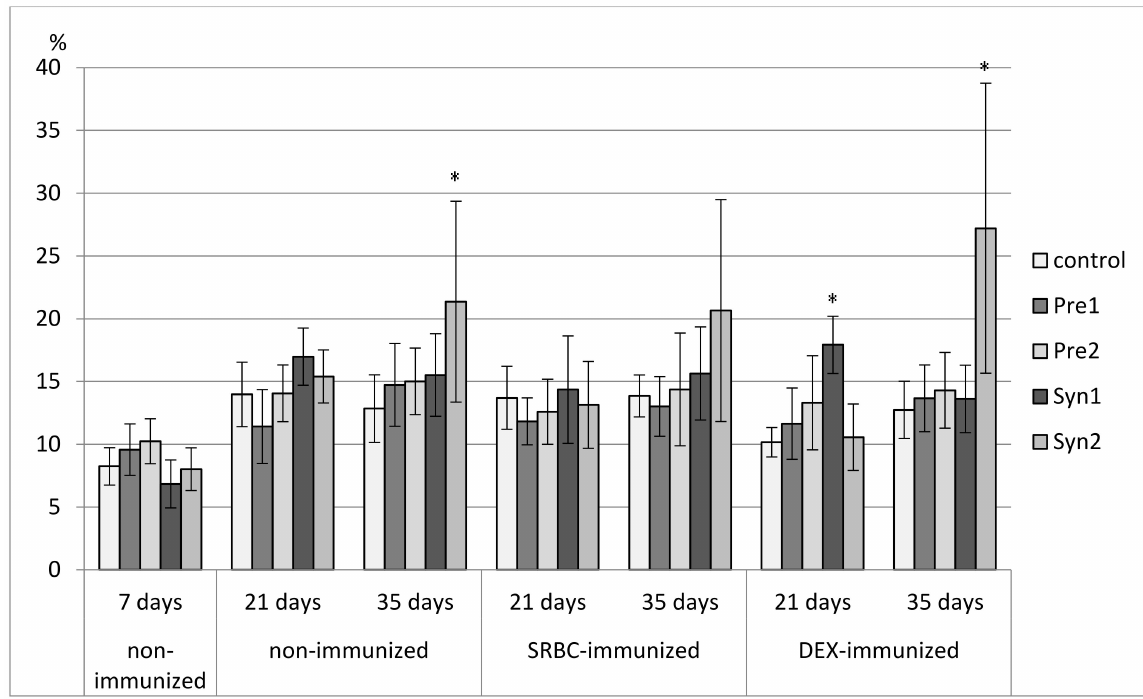
Figure 12. The percentage of CD3 + TCR γδ + cells in the spleen of chicken broilers after in ovo injection of the investigated prebiotics or synbiotics. The data are expressed as the mean ± SD. Data with a symbol (*) denote a significant difference with respect to the control group ( p <